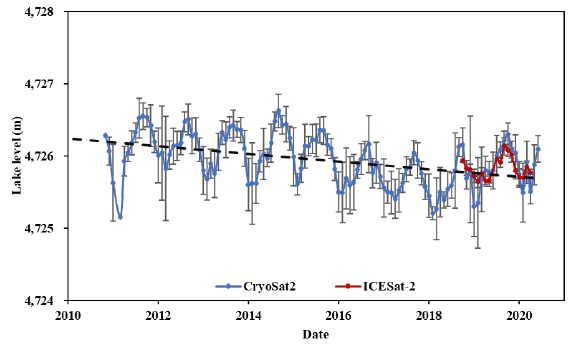
Figure 5 . The lake level during the overlap period between ICESat-2 (red) and CryoSat-2 (black).